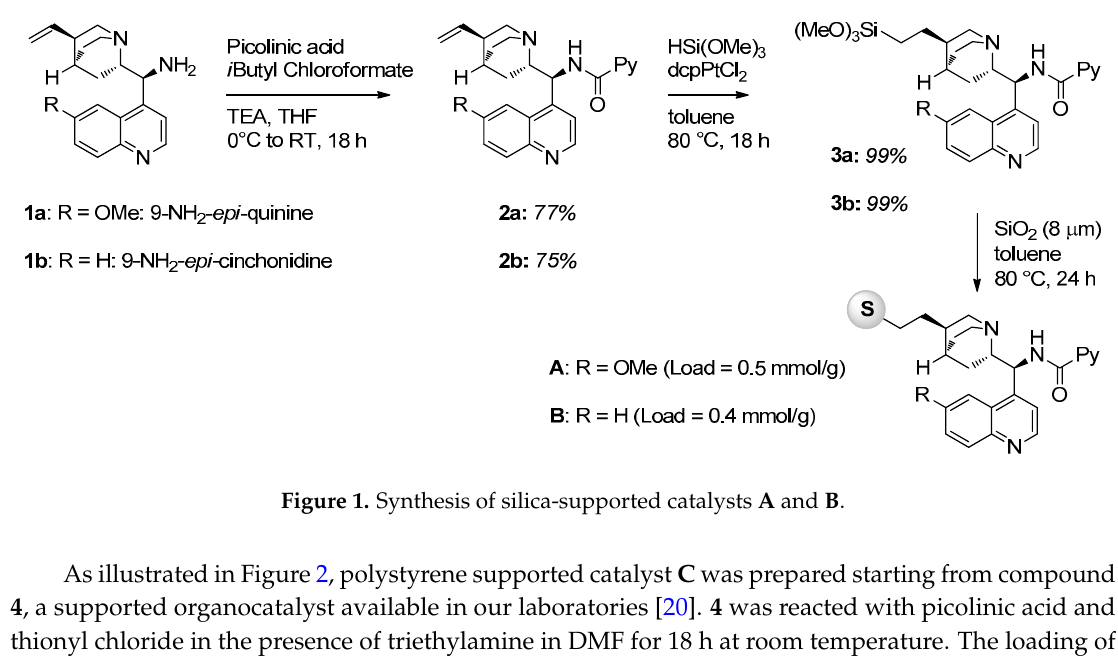
Figure 2. Synthesis of polystyrene-supported catalyst C .